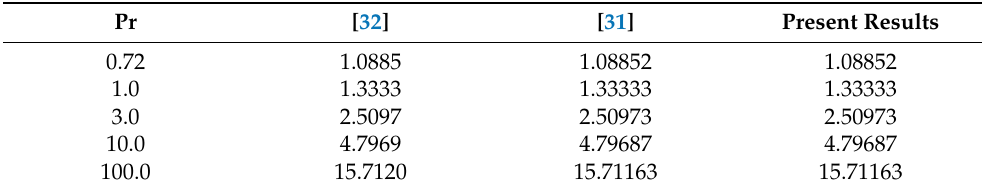
Table 3. Comparison solutions for − θ (cid:48) ( 0 ) (Nusselt number). When φ Cu = φ Fe Ec = Γ =